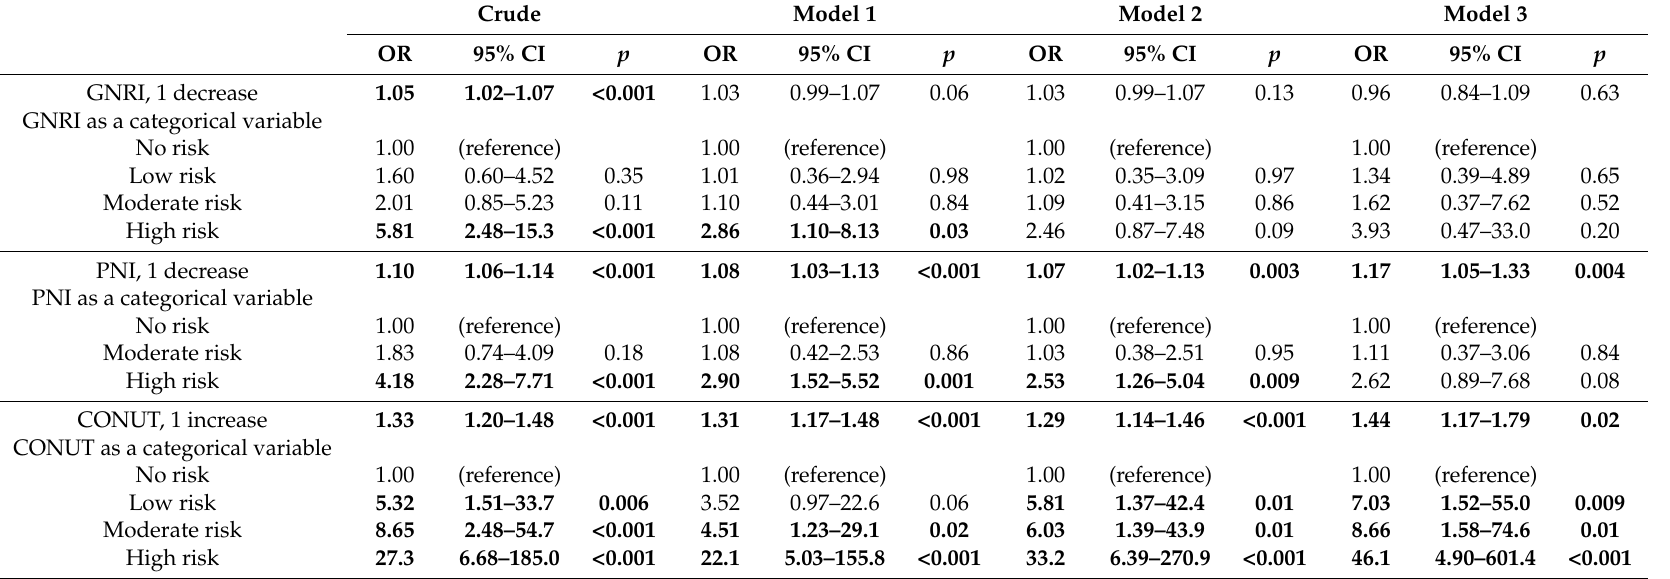
Table 3. Multivariate logistic regression analyses for the occurrence of